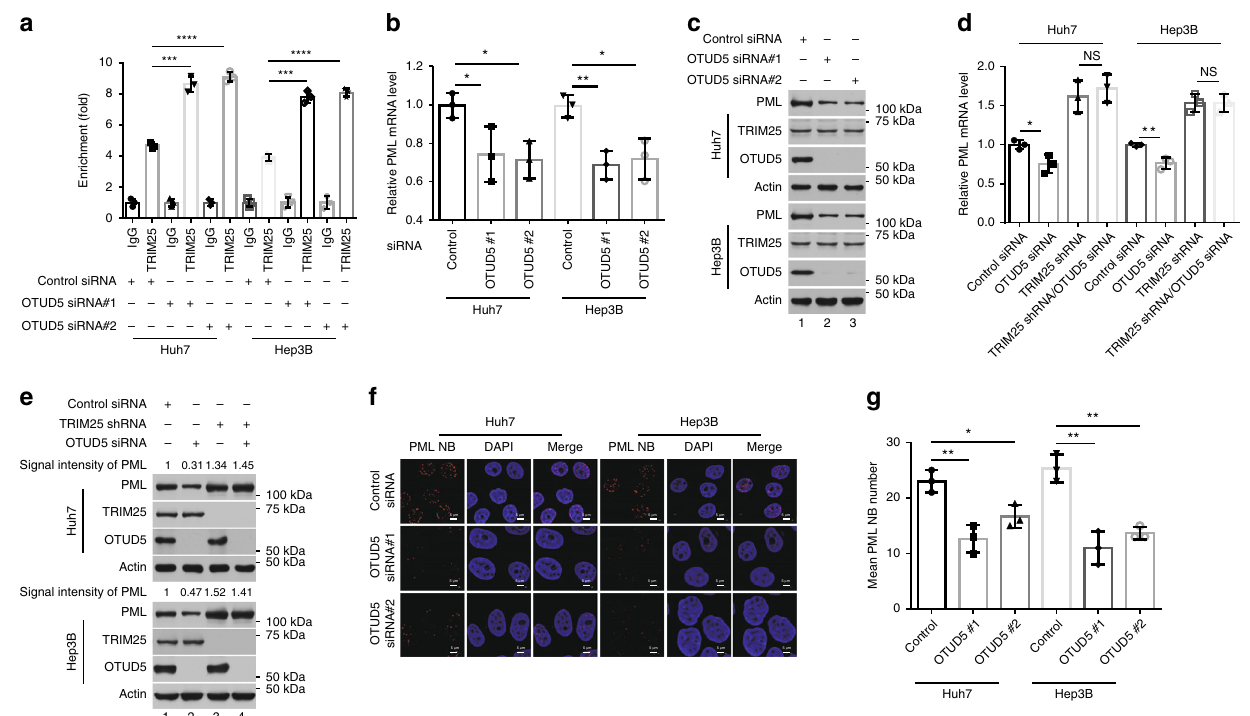
Fig. 6 OTUD5 knockdown inhibited PML expression and PML-NBs formation. a TRIM25 recruitment onto the PML promoter was increased in response to OTUD5 depletion. Data indicate the means±SD, n = 3 for technical replicates. *** p = 0.0002 (siControl versus siOTUD5 #1 in the Huh7 cells), **** p <0.0001 (siControl versus siOTUD5 #2 in the Huh7 cells), *** p = 0.0001 (siControl versus siOTUD5 #1 in the Hep3B cells), **** p <0.0001 (siControl versus siOTUD5 #2 in the Hep3B cells), two-tailed unpaired t -test. b , c OTUD5 depletion inhibited the expression of PML. Data indicate the means±SD from three biological replicates. * p = 0.0498 (siControl versus siOTUD5 #1 in the Huh7 cells), * p = 0.0138 (siControl versus siOTUD5 #2 in the Huh7 cells), ** p = 0.0051 (siControl versus siOTUD5 #1 in the Hep3B cells), * p = 0.0173 (siControl versus siOTUD5 #2 in the Hep3B cells), two-tailed unpaired t -test. d , e OTUD5 knockdown inhibited PML expression in a TRIM25-dependent manner. d Data represent the means±SD from three biological replicates. * p = 0.0320 (siControl versus siOTUD5 in the Huh7 cells), ** p = 0.0058 (siControl versus siOTUD5 in the Hep3B cells), two-tailed unpaired t -test. NS, non-signi fi cance. e Western blotting was performed for the proteins from the whole-cell extract using the antibodies indicated. PML was quanti fi ed by Image-Lab software (Version 3.0 beta). f Depletion of OTUD5 reduced the formation of PML-NBs in the Huh7 and Hep3B cells. Representative images are shown. Scale bar, 5 μ m. g The average number of PML-NB foci per cell was counted for three independent experiments and plotted as indicated. Data represent the means±SD; n = 50 cells, data were pooled across three experiments. ** p = 0.0051 (siControl versus siOTUD5 #1 in the Huh7 cells), * p = 0.0191 (siControl versus siOTUD5 #2 in the